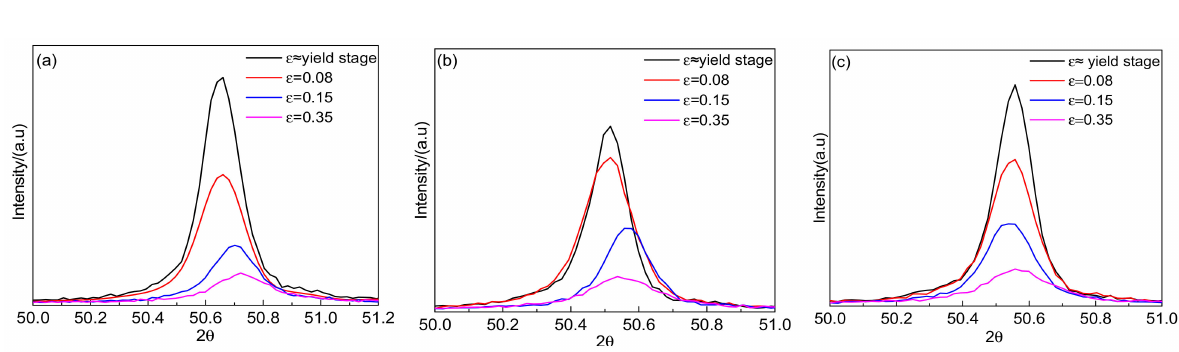
Figure 4. XRD pattern of (111) γ at different strain of ( a ) 12Cr–CN, ( b ) 19Cr–0.7N, ( c ) 19CrSi–0.7N. ρ is average dislocation density in material (m − 2 ), which can be measured by X-ray diffraction (XRD) experiments or simulated based on the models. The β is the full width at half-maximum of the XRD diffraction peak on the crystal plane, b is the burger vector. The calculations corresponding to the 2 θ crystal plane positions (111) γ , (200) γ , (220) γ , and (311) γ results are shown in Table